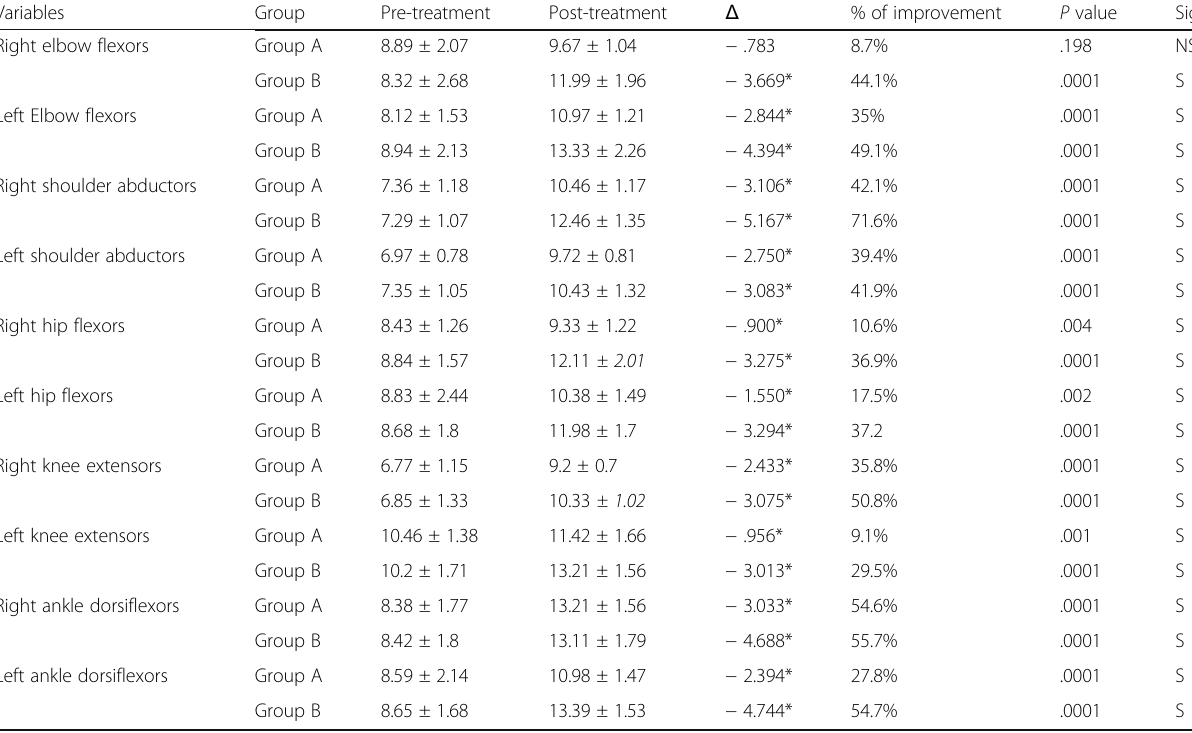
Table 5 Comparison mean value of muscle strength before and after treatment for both groups A and B Variables Group Pre-treatment Post-treatment Δ % of improvement P value Sig Right elbow flexors